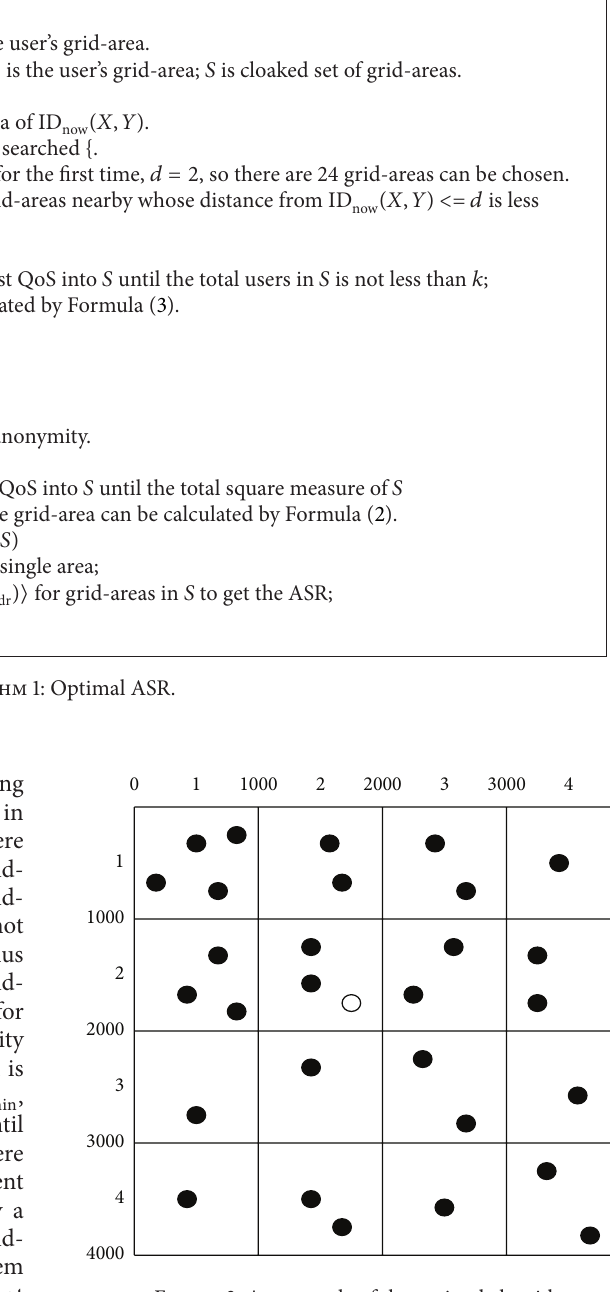
Figure 3: An example of the optimal